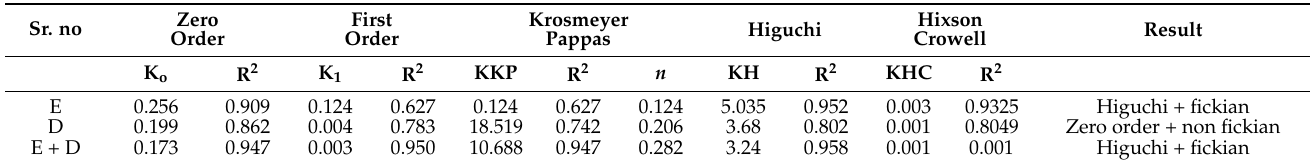
Table 2. Kinetic modeling showing mechanism of drug release from topical